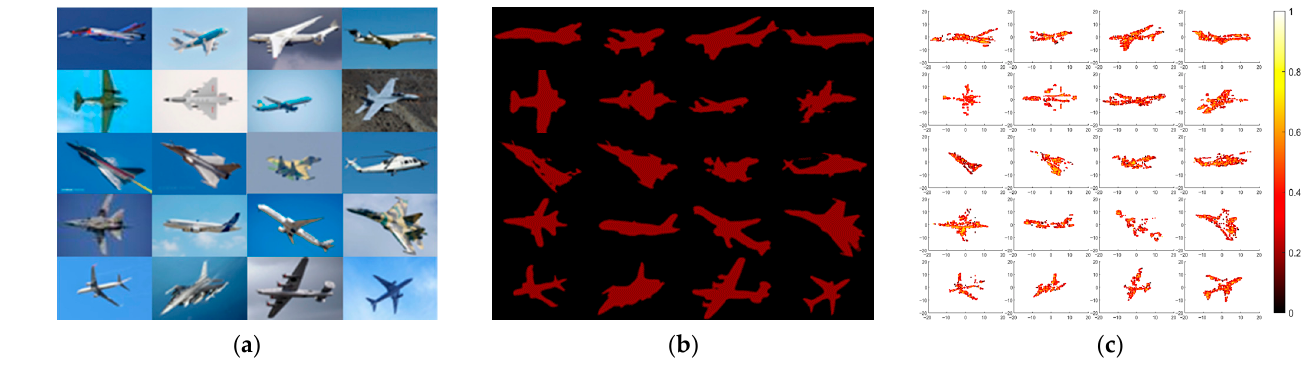
Figure 8. Some examples of the pseudo-measured block targets generation: ( a ) The origin images in dataset; ( b ) The segmented images; ( c ) The pseudo-measured targets.